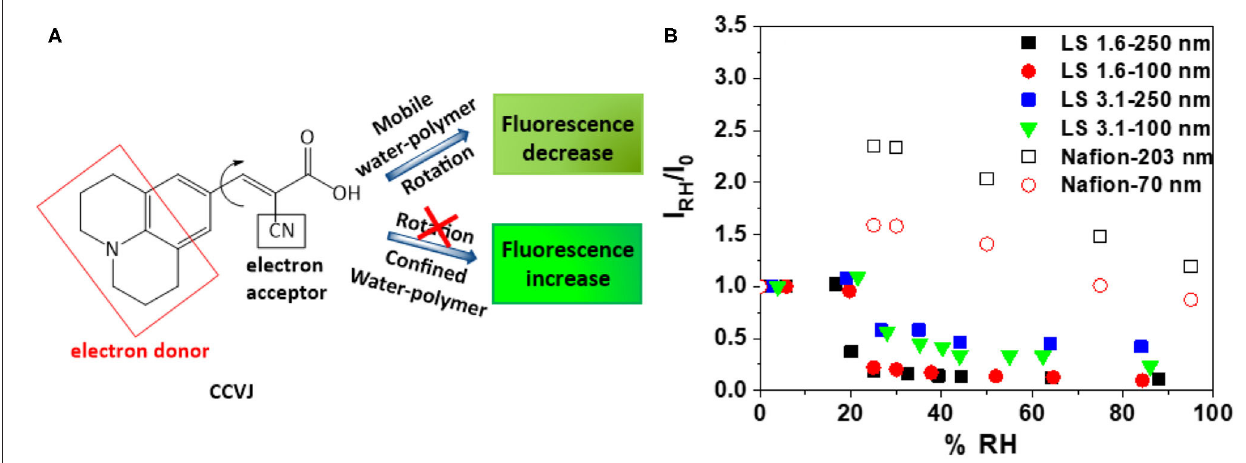
FIGURE 4 | (A) Chemical structure and working principle of fluorescent rotor probe CCVJ; and (B) relative fluorescence intensity (I RH /I 0 ) of CCVJ in 250 nm-thick LS 1.6, LS 3.1, and Nafion films as a function of %RH [( λ exc ) CCVJ ∼